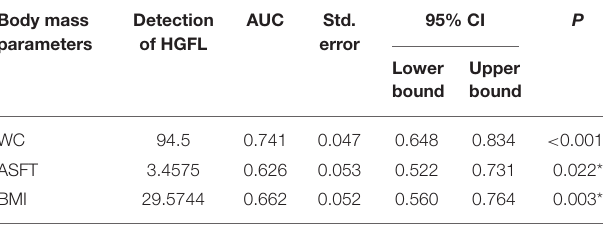
TABLE 4 | ROC curve analysis of body mass parameters (WC, BMI, and ASFT) to identify HGFL. Body mass Detection parameters of HGFL